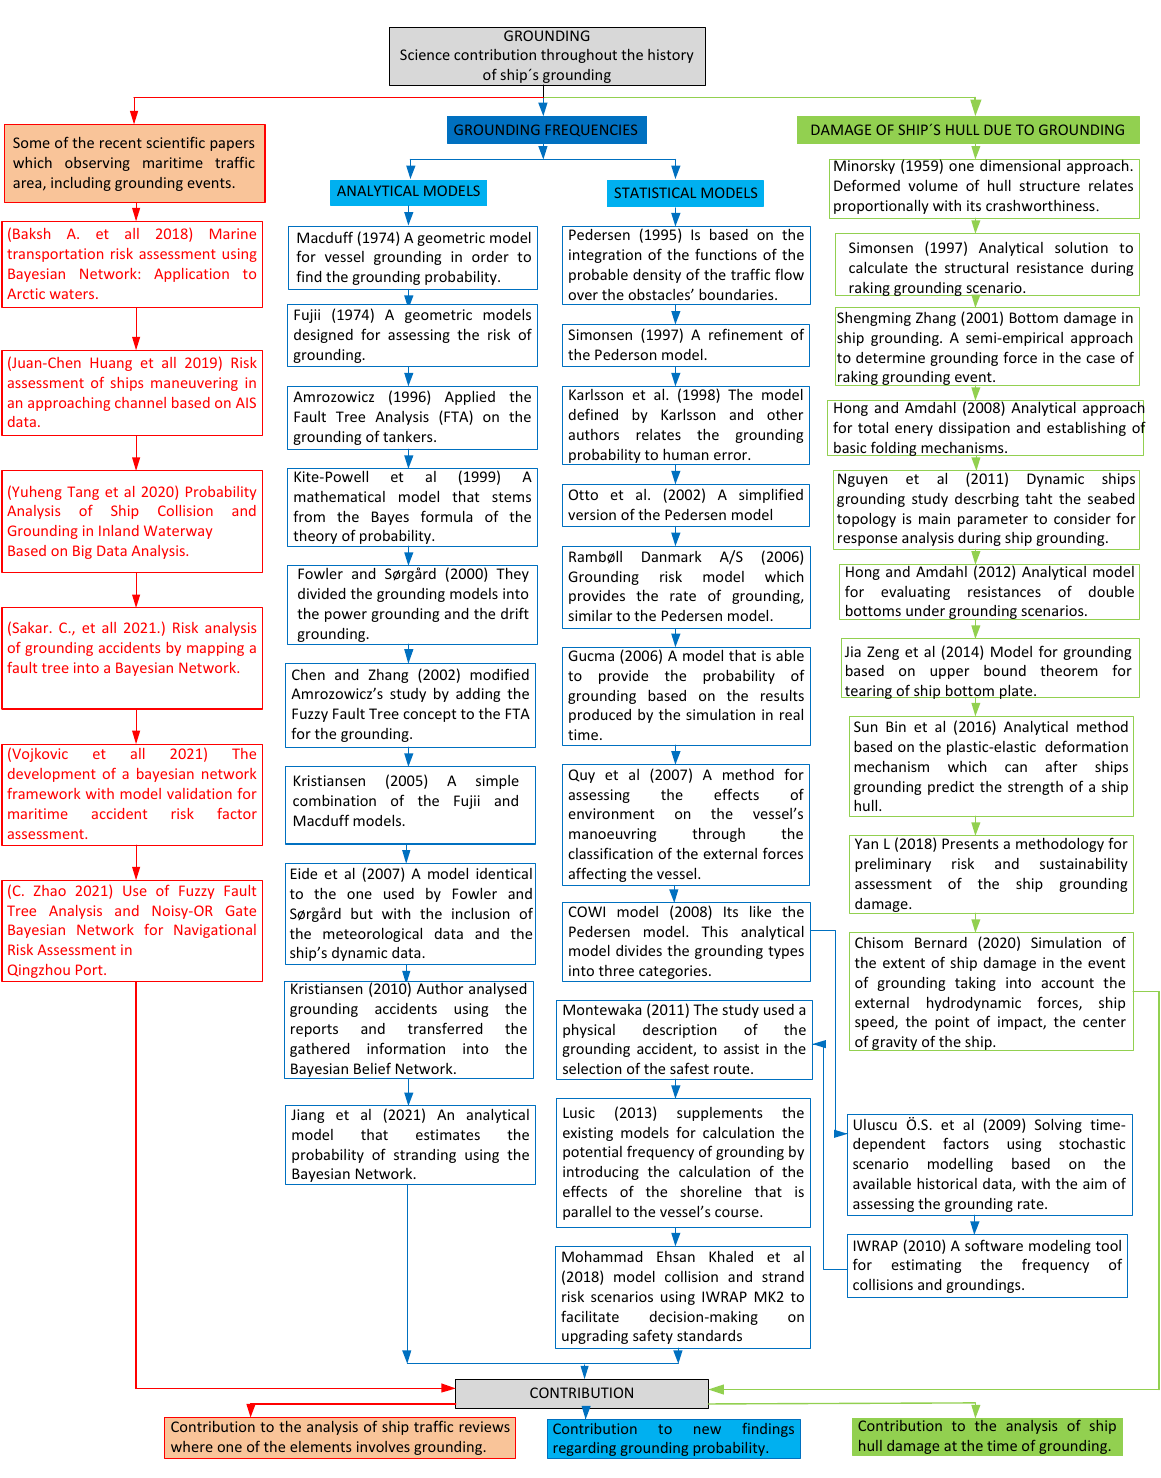
Figure 1. Diagram of a science contribution throughout the history of ship grounding [1,3,6–41].